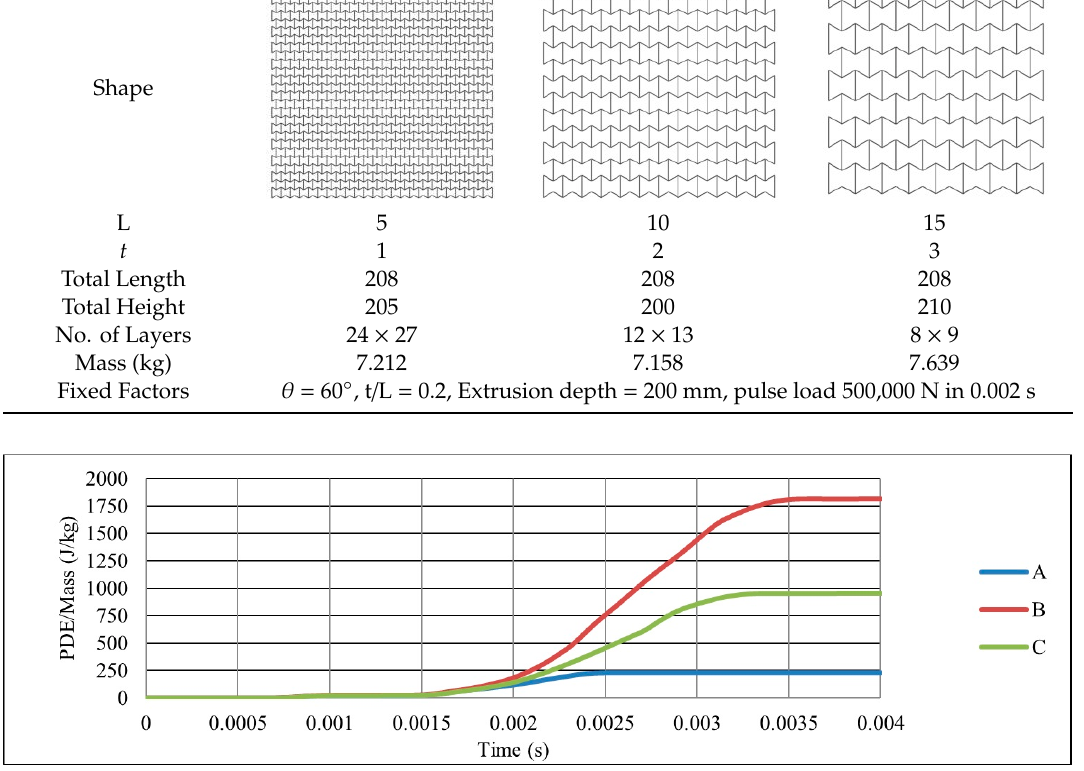
Figure 8. Ratio of PDE/Mass with respect to time, for three different cell dimensions A, B and C with θ = 60°, t/L = 0.2, subjected to the same loading conditions.